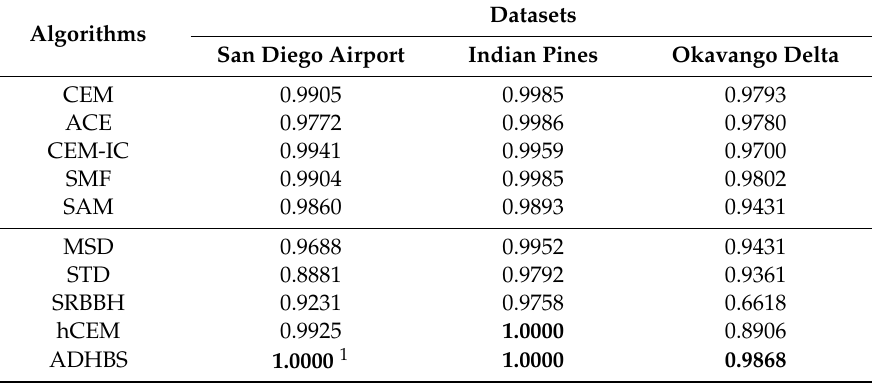
Table 1. Area under the ROC curves (AUC) value comparison for three datasets (keep four decimal places).